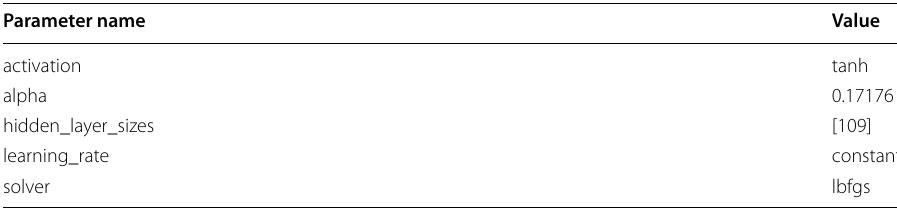
Table 108 Modes of MLP tuned hyperparameter values for experiments with the keylogging dataset